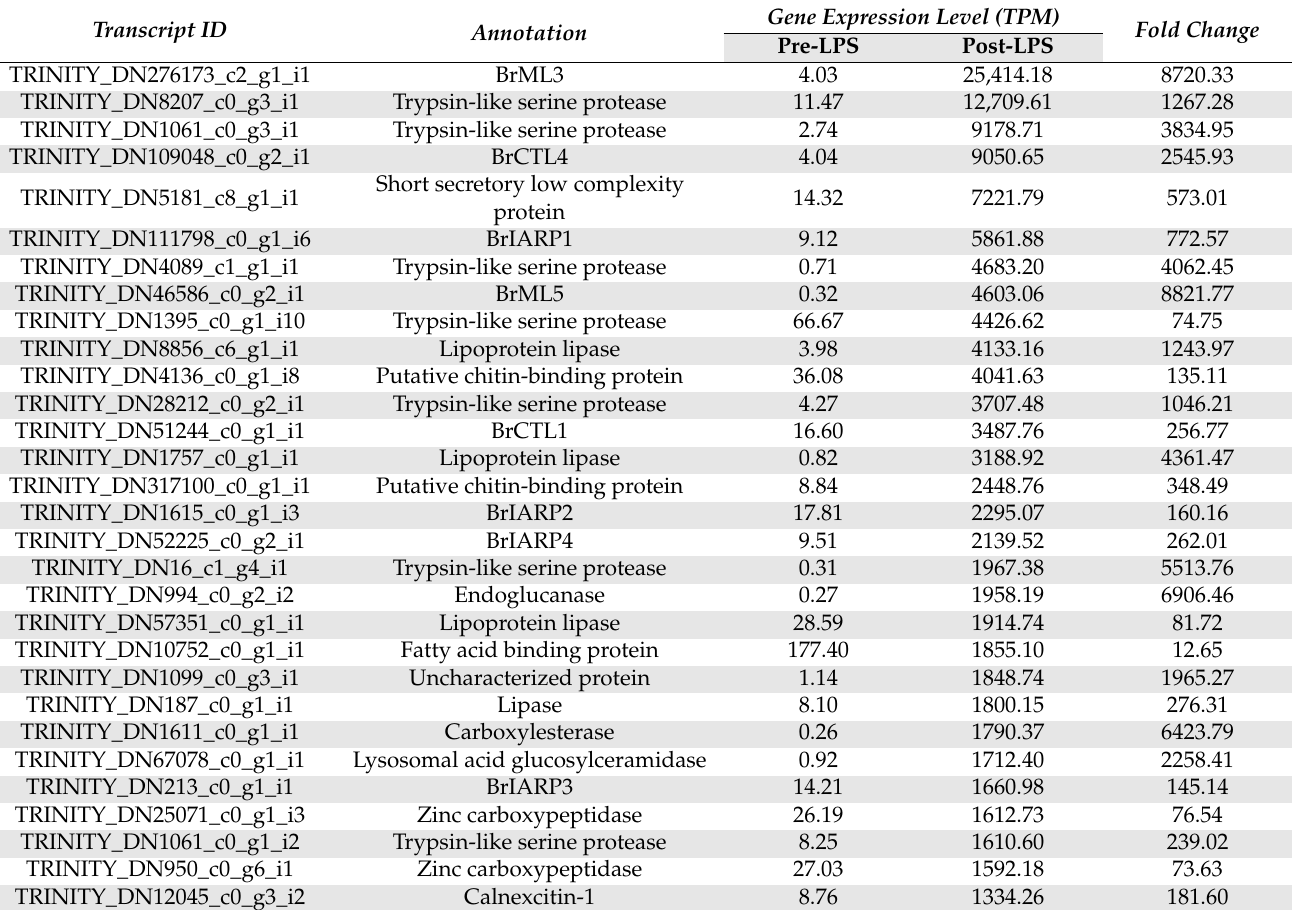
Table 2. List of top 30 upregulated DEGs. Bonferroni-corrected p -value always equaled